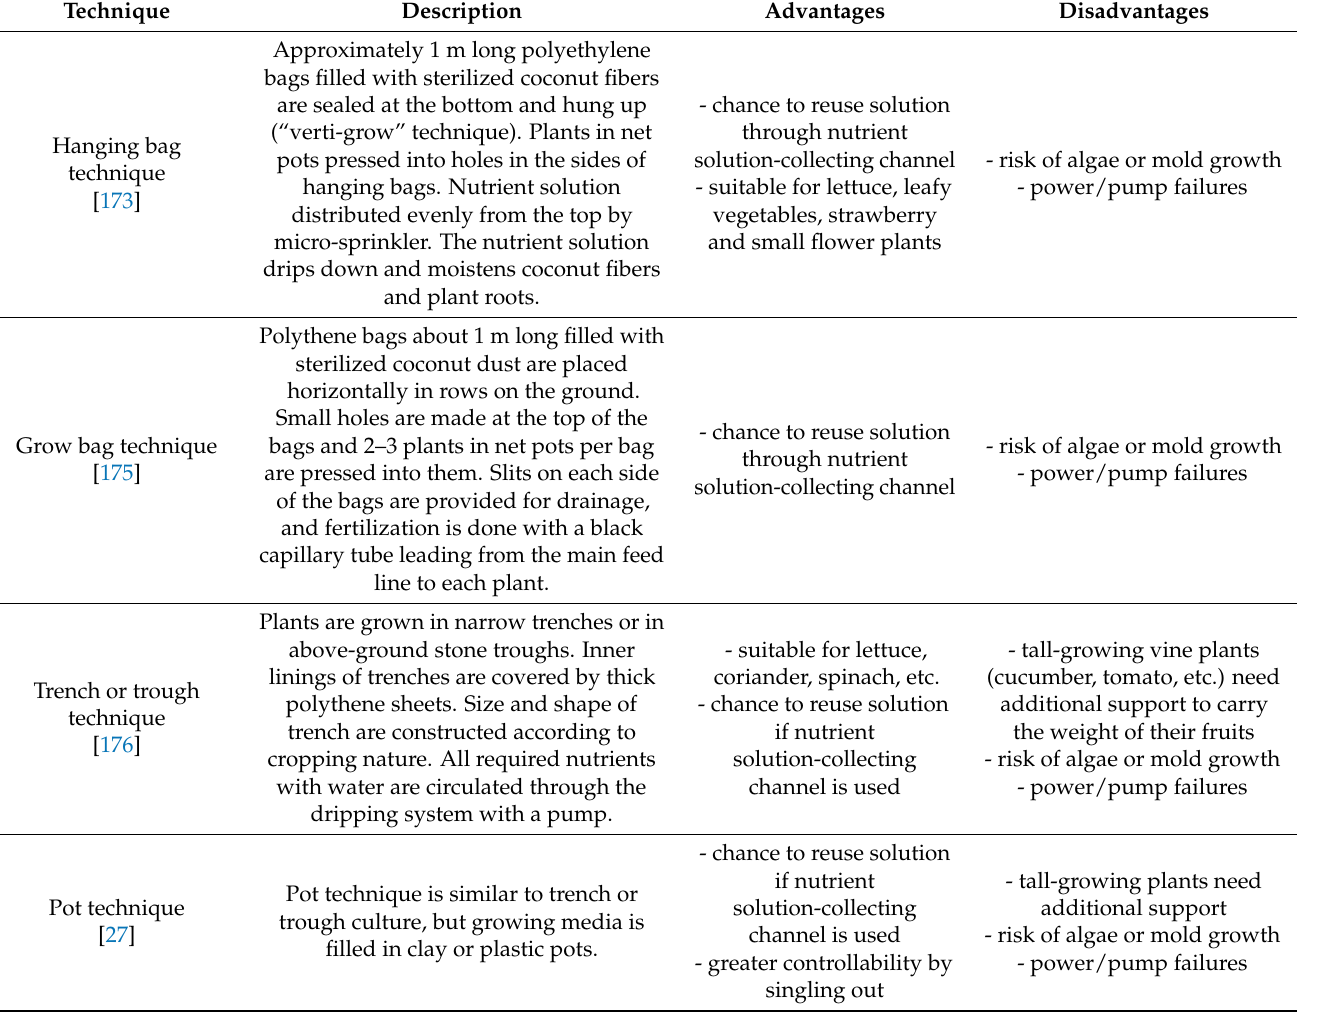
Table A2. Solid media culture techniques or aggregate systems.